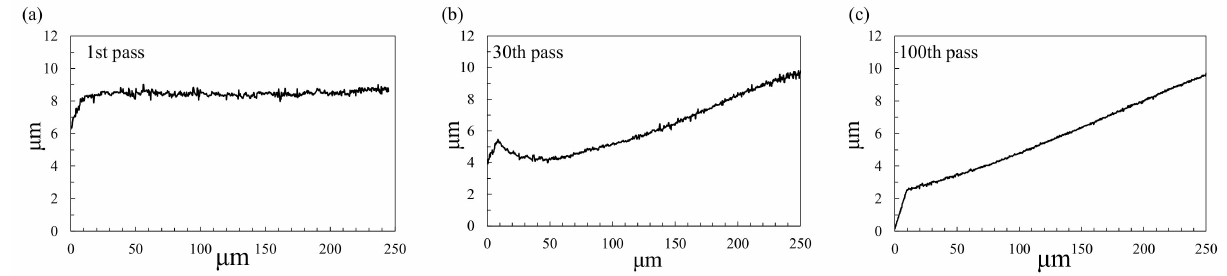
Figure 7. Cross-sectional profile perpendicular to the laser-scanning direction of different processing pass numbers shown in ( a – c ) for PLG at a pulse pitch of 2 µ